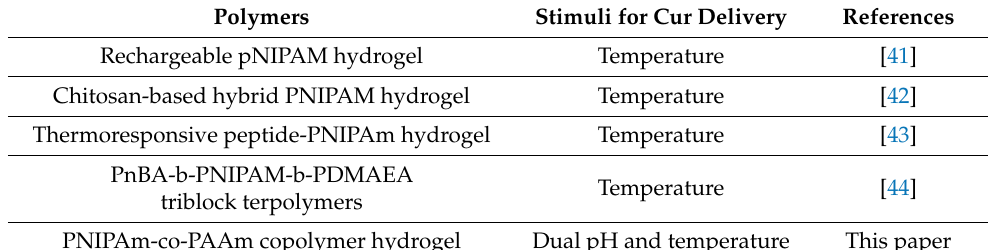
Table 2. Different design of PNIPAM-based copolymers for Cur delivery.